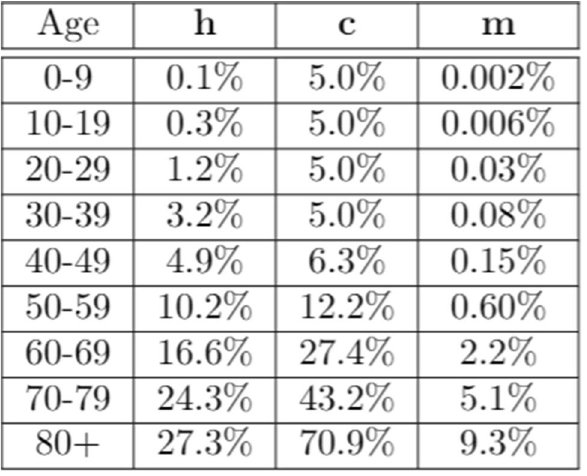
Figure 2. COVID-19 age